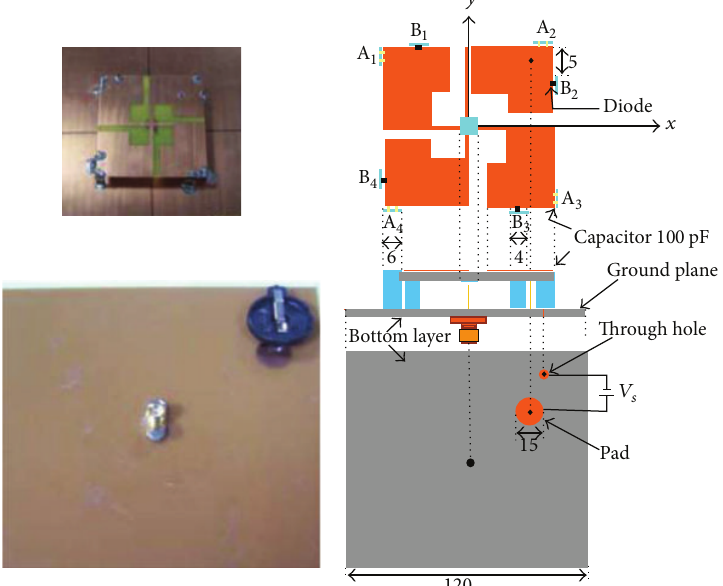
Figure 9: Layout of a reconfigurable CP microstrip array and the finished prototype (with permission from